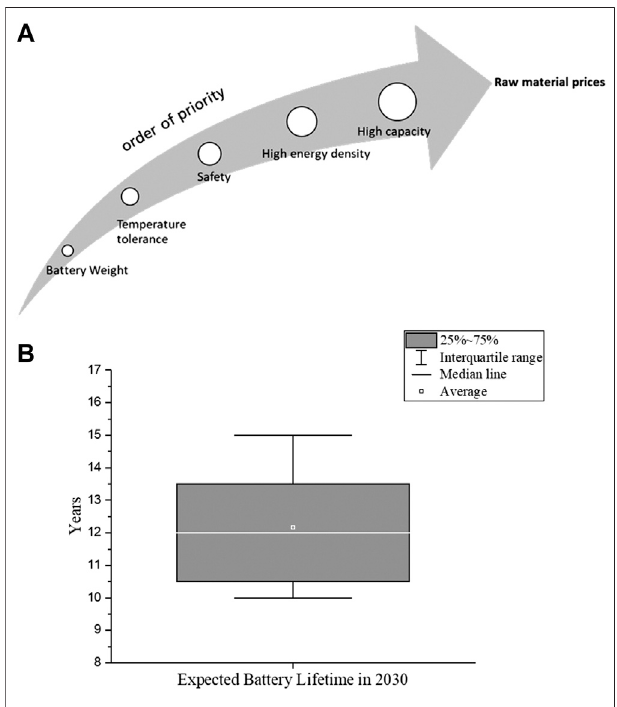
FIGURE 2 | (A) Impact of in fl uence factors on battery chemistry developments (B) Expected battery lifetime in 2030 if the important in fl uence factors are improved.